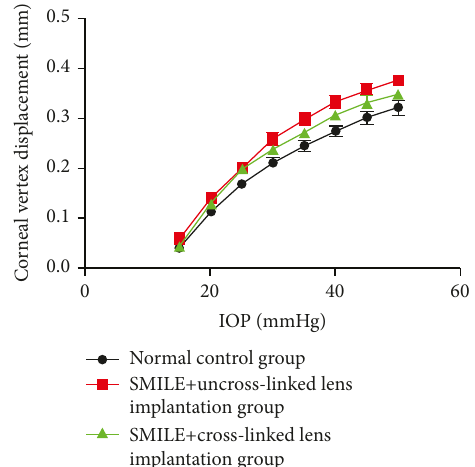
Figure 4: Corneal vertex displacement as a function of increased intraocular pressure.